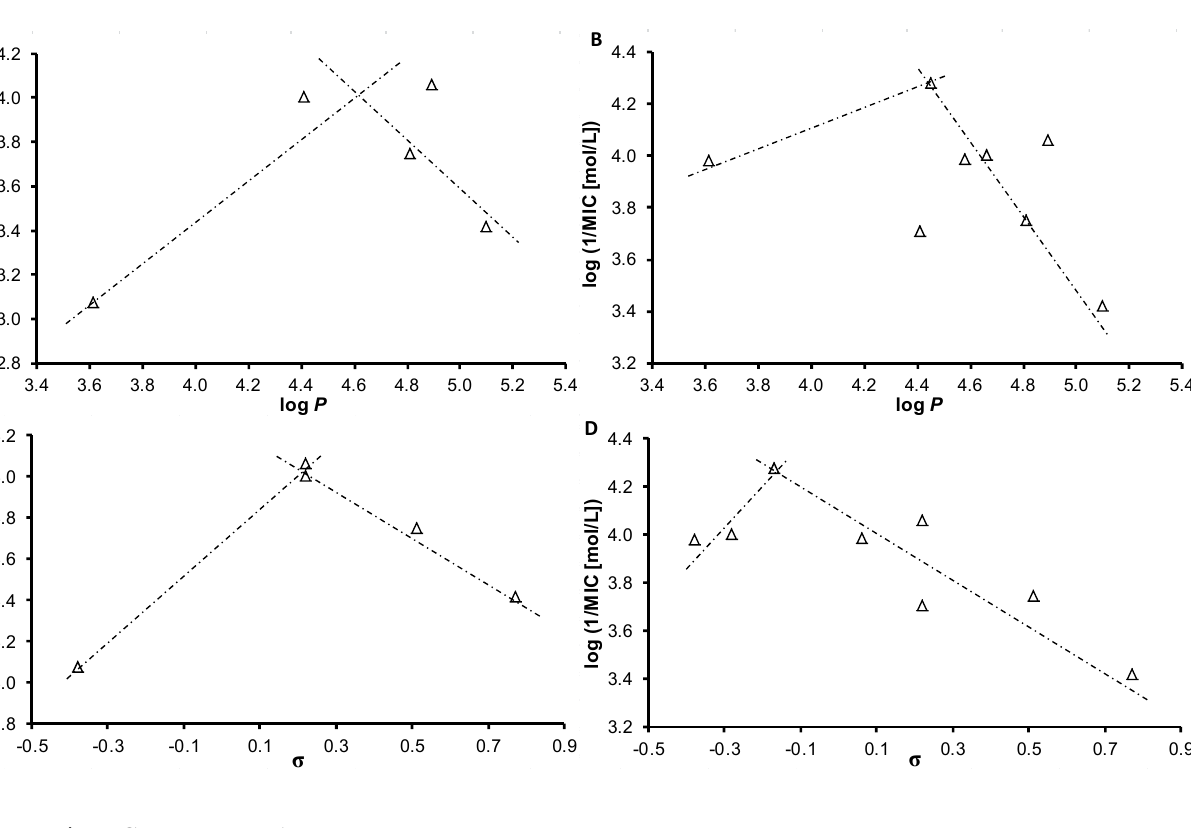
Figure 3. Dependences of in vitro antimycobacterial activity against M. marinum log(1/MIC [mol/L]) on lipophilicity (Figure 3A) and on N -substituent electronic Hammett’s σ parameters (Figure 3C) or in vitro activity against M. smegmatis log(1/MIC [mol/L]) on lipophilicity (Figure 3B) and on N -substituent electronic Hammett’s σ parameters